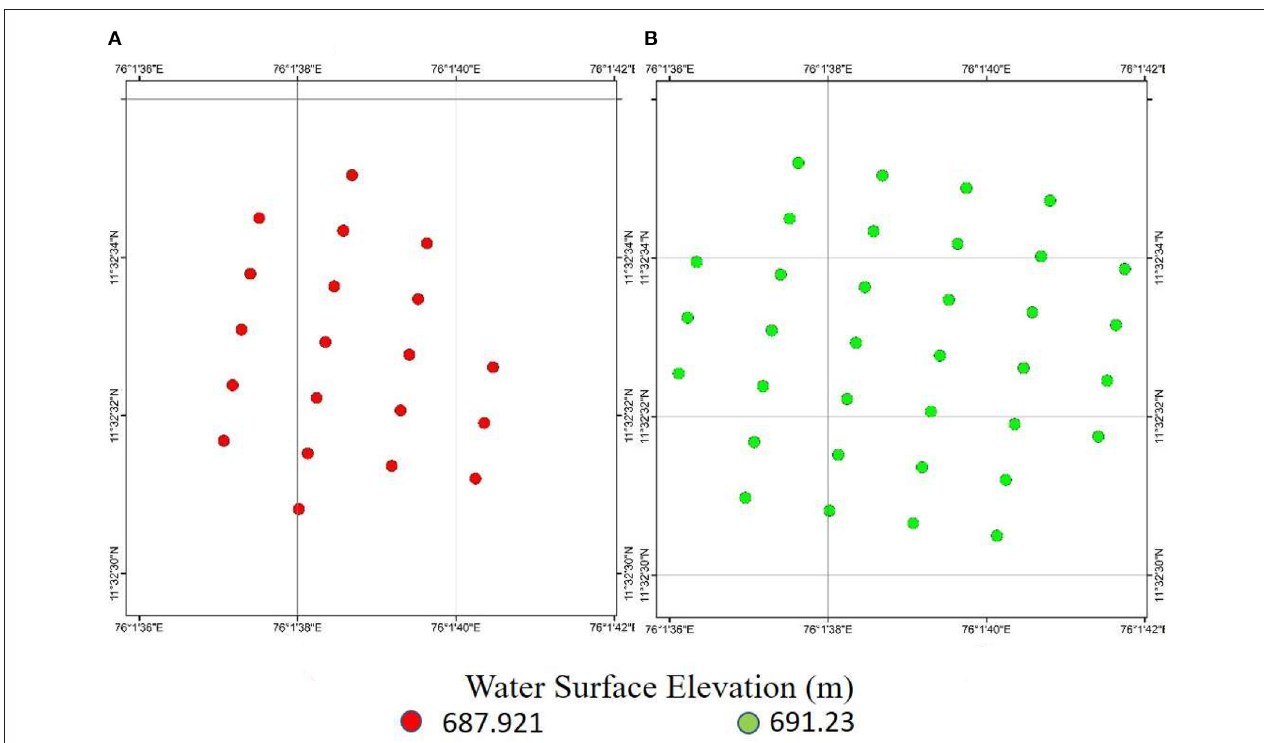
FIGURE 7 | Variation in water level in Pookode Lake as observed by synthetic SWOT data before and after flood in (A) 2015 and (B) 2020.